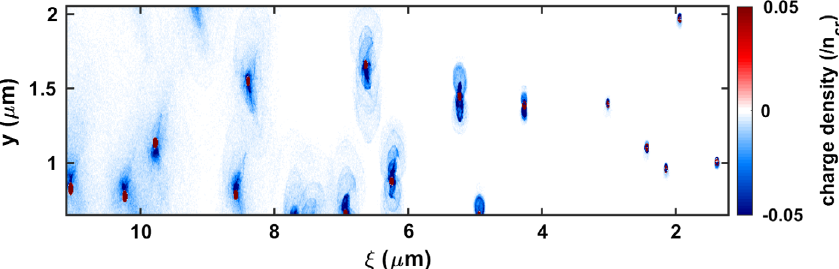
FIG. 5. Close-up of the charge density of expanding clusters from a 2D moving-window particle-in-cell simulation. Ion clusters are plotted in red, electrons in blue. The circular clusters were initialised with density of 1 . 5 × n centered outside of the depicted area at 17 μ m.